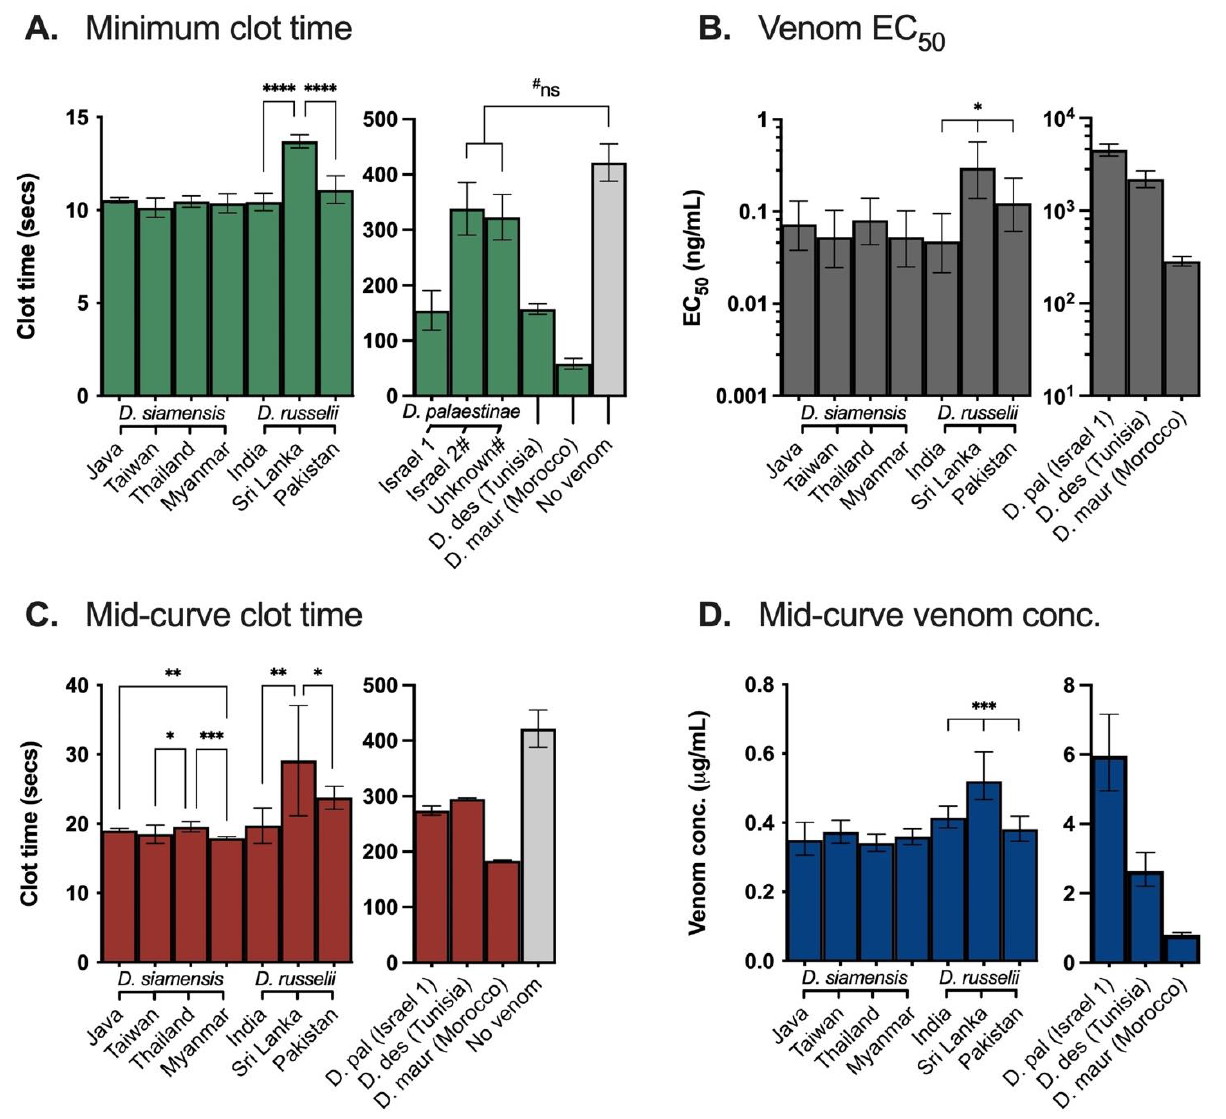
Figure 3. Clotting parameters of procoagulant activity of Daboia venoms incubated with human plasma: ( A ) Minimum clot time of plasma at venom saturation point (20 µ g/mL for Asian clade ( left ), 30 µ g/mL for Afro-Arabian clade ( right )). ( B ) Venom concentrations required to induce half the maximal response (EC 50 ) of procoagulant activity. Data are extrapolated from 9-point dose-response curves (0.05–30 µ g/mL) using non-linear regression, normalised between maximal response (minimum clot time) and no response (negative control). Lower EC 50 s represent greater venom potency. ( C ) Mid-curve clot times by venoms tested at nine concentrations between 0.05–30 µ g/mL. ( D ) Venom concentrations that induce mid-curve clot times (panel C ), calculated via non-linear regression and normalised between clotting response at 30 µ g/mL and at 0.05 µ g/mL. Lower values represent greater venom potency. ( A – D ) Venom data are the mean ( A , C ) or best-fit values ( B , D ) with 95% confidence intervals of at least three replicates; negative control (clot time with no venom) is cumulative mean ± SD of negative controls (50 replicates) conducted over multiple coagulation assays; statistics displayed are the results of one-way ANOVA and Tukey’s tests of intra-species comparisons (i.e., comparisons of multiple venom samples from the same species); **** = p < 0.0001, *** = p < 0.001, ** = p < 0.01, * = p < 0.05; D. pal = D palaestinae , D. des = D. deserti , D. maur = D. mauritanica . # Venoms were not procoagulant (ns = not significant ( p > 0.05); unpaired t-tests of venom vs no venom clot times) and were thus excluded from analyses ( B – D ).